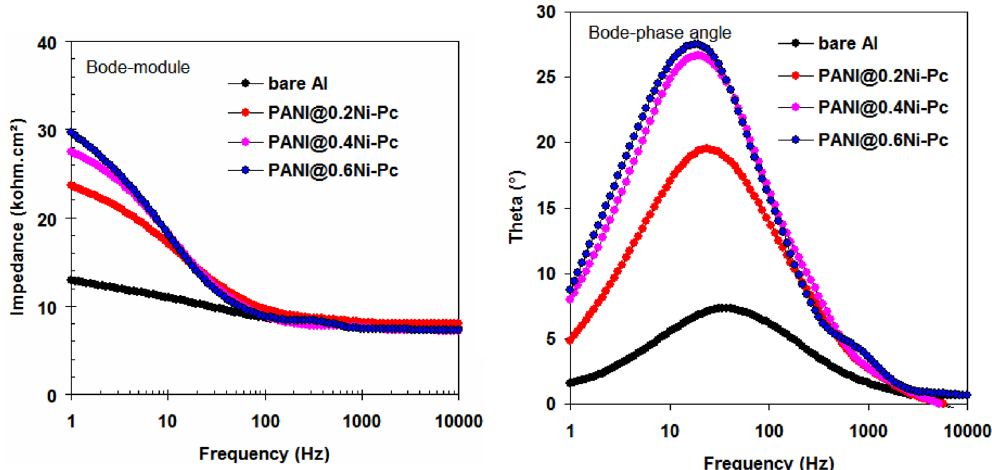
Figure 5. Bode-module and Bode-phase angle plots for pristine Al foil and coated Al foil with PANI@Ni-Pc composites in LiN(SO